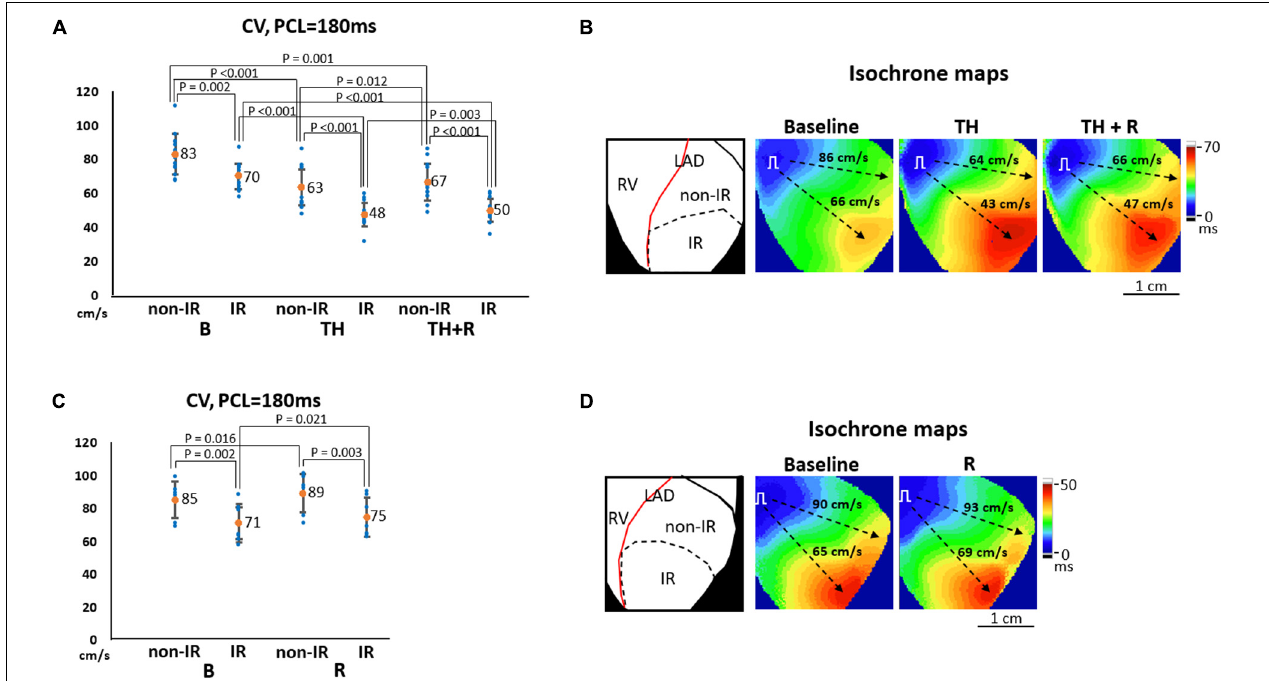
FIGURE 5 | Effects of therapeutic hypothermia (TH) and rotigaptide (R) on conduction velocity (CV). (A,C) Summarized results of CV at pacing cycle length (PCL) of 180 ms in the TH ( n = 14, repeated-measures ANOVA with post hoc LSD analysis) and non-TH groups ( n = 7, Student’s t -test), respectively. TH slowed CV and